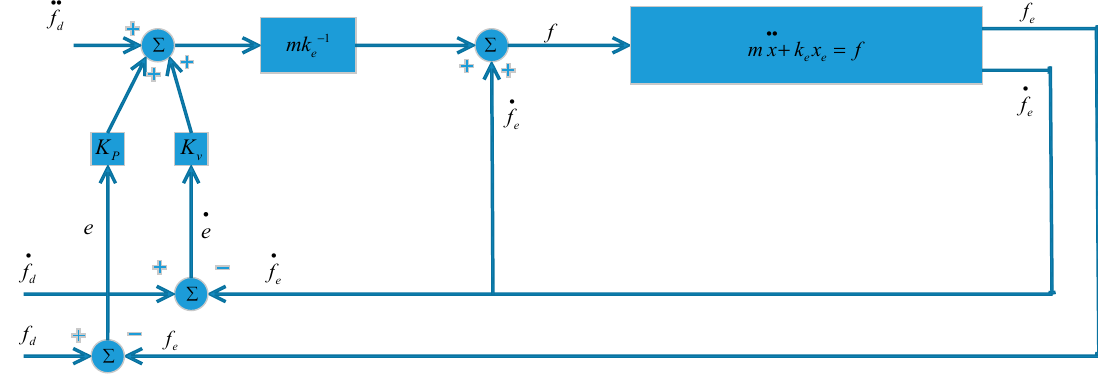
− Control law Figure 5. Adaptive control structure. 2.6. Force Control Case For the force control case, however, it is very different from the motion control case because the dynamic equation is very different. For the motion control case, the dynamic equation is ( )